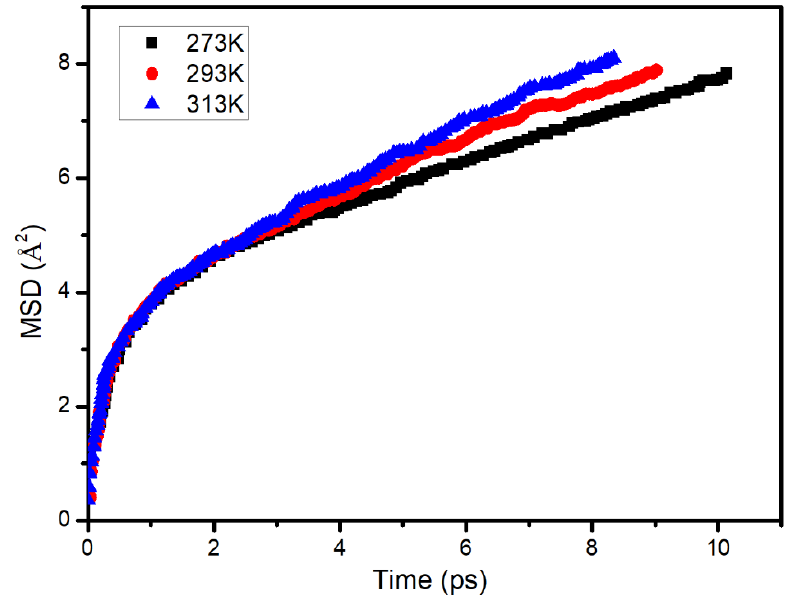
Figure 20. Change in the mean square displacement over time of sunflower oil in the aged asphalt.